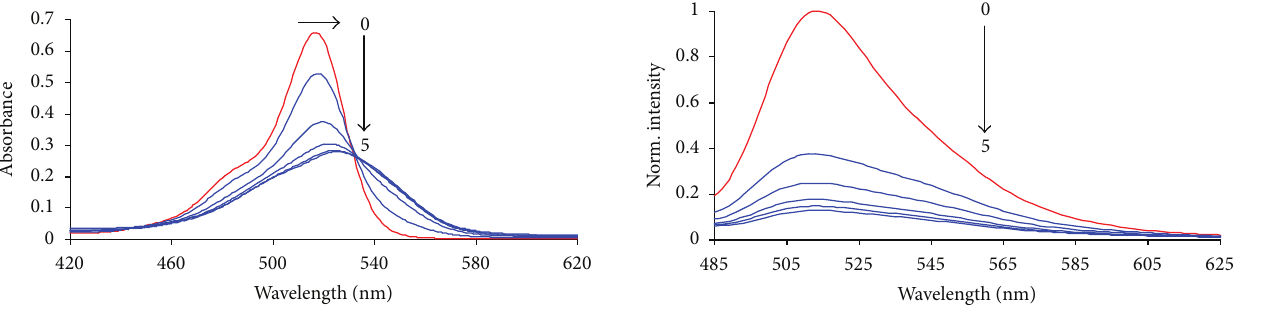
Figure 3: Absorption spectrum of EN ( 1 × 10 −5 M; red color) in the presence of colloidal SnO 2 ( 0 – 5 × 10 −4 M; blue color) in water. The arrow indicates the absorbance decreases with red shift on increasing concentration of colloidal SnO 2 .